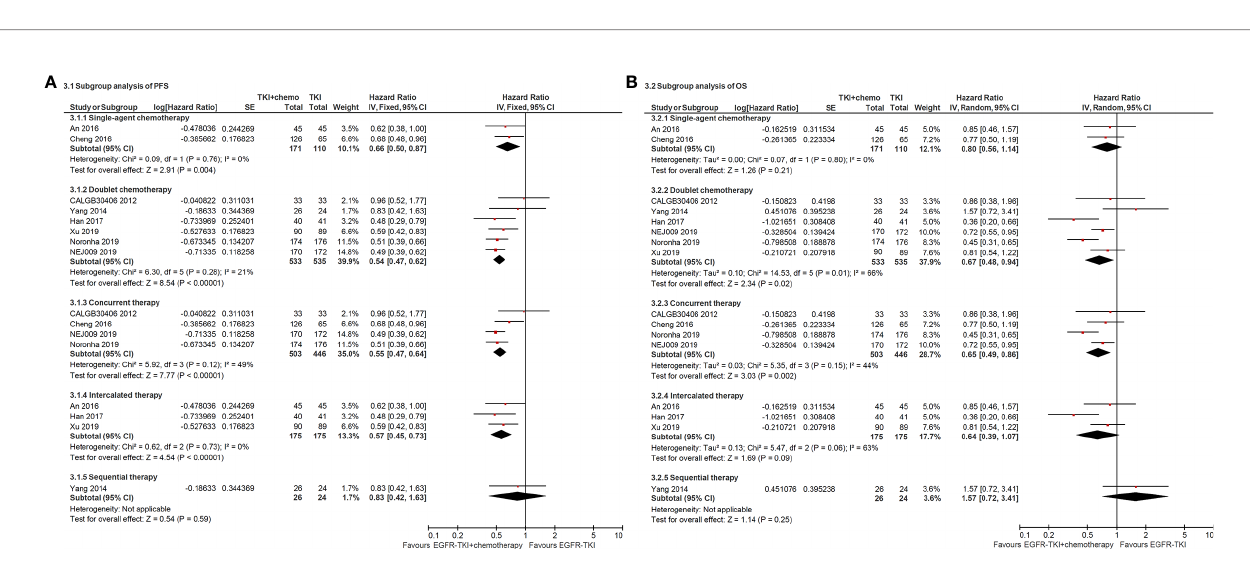
FIGURE 3 | Forest plot of subgroup analysis of progress-free survival (A) and overall survival (B) .